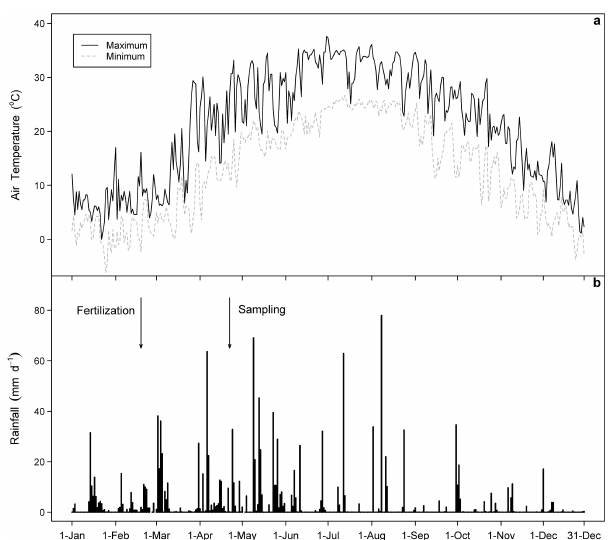
Figure 2. Daily (a) air temperatures and (b) precipitation during 2012.